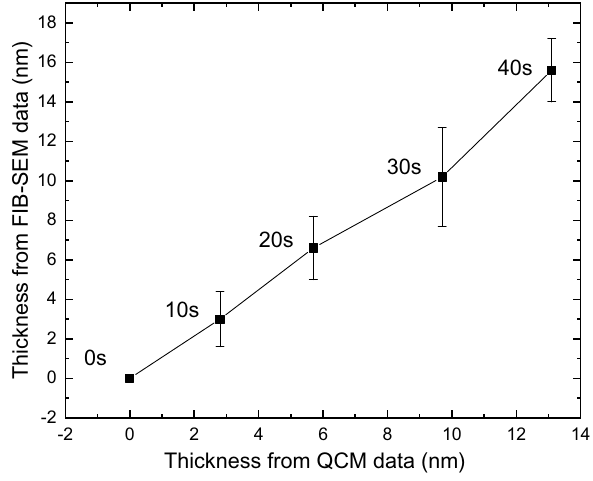
Fig. 2 Graphical representation showing the variation of thickness of deposited SiO films on LSM Al alloys as a function of deposition x times (measured using QCM set-up) and thickness measurements via FIB-SEM